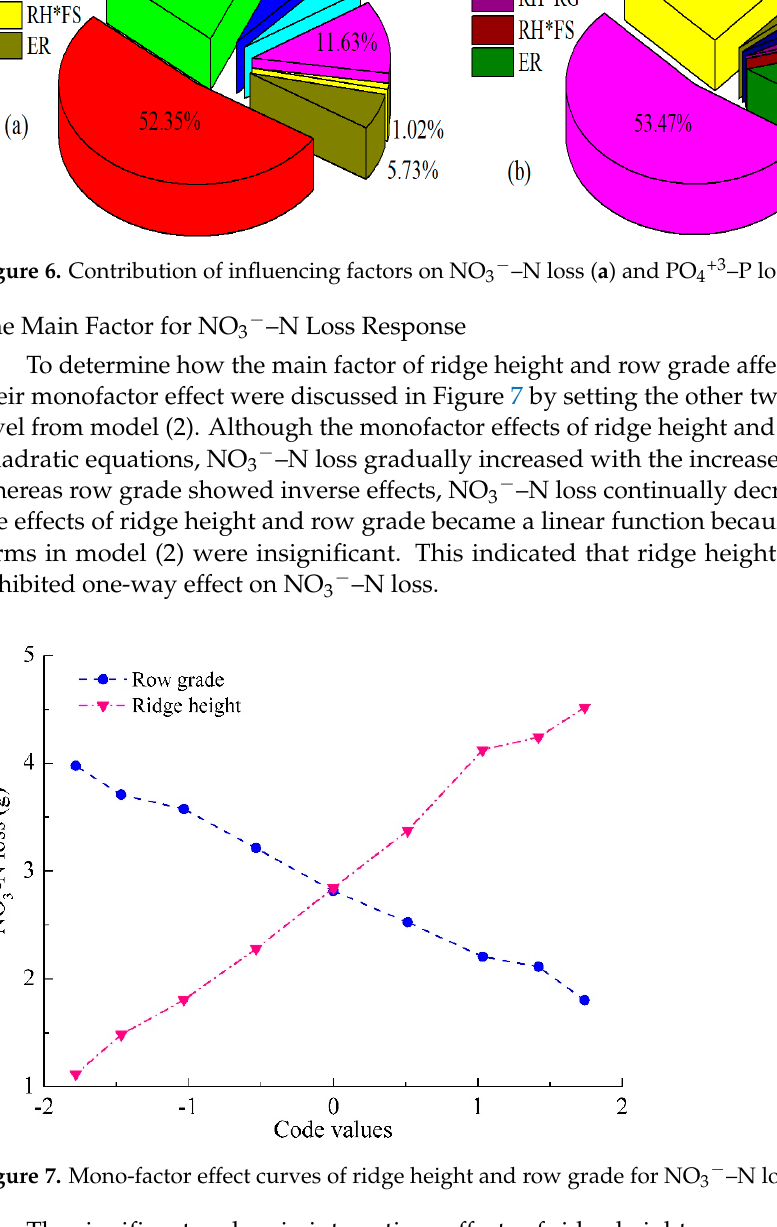
Figure 6. Contribution of influencing factors on NO 3 − –N loss ( a ) and PO 4+3 –P loss ( b ).